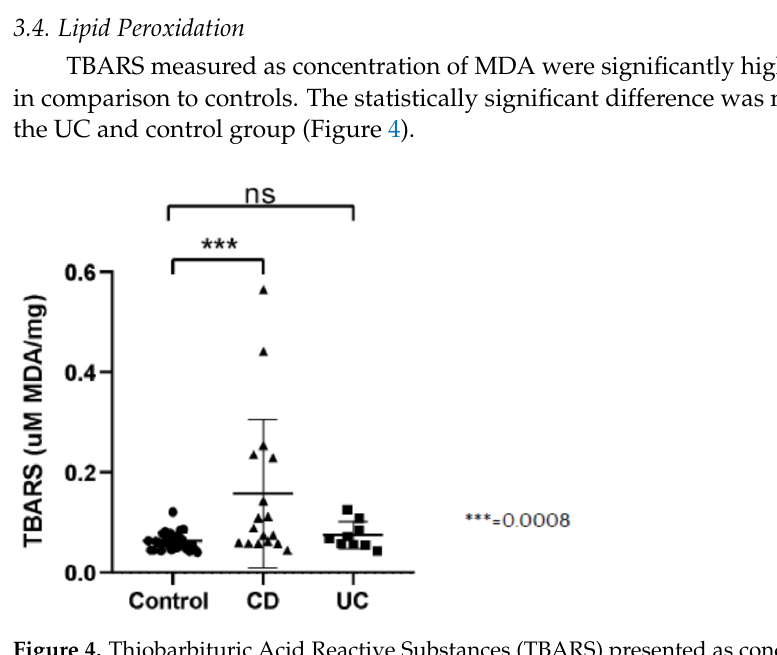
Figure 3. Activity of total cyclooxygenase (COX, U/mg sample), cyclooxygenase-1 isoform (COX-1, percentage of total COX activity) and cyclooxygenase-2 isoform (COX-2, percentage of total COX activity) per milligram tissue sample in healthy subjects (Control), in patients with Crohn’s disease (CD) and ulcerative colitis (UC).